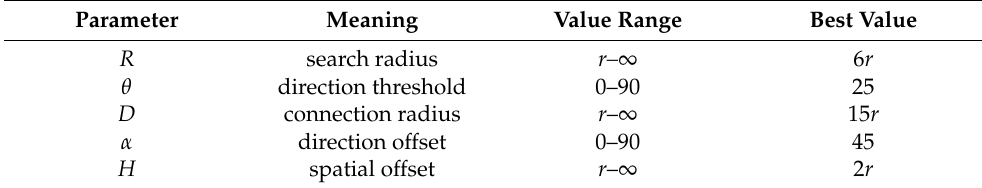
Table 2. Parameter settings for connecting discontinuity traces. Parameter Meaning Value Range Best Value R search radius r– ∞ 6 r θ direction threshold 0–90 25 D connection radius r – ∞ 15 r α direction offset 0–90 45 H spatial offset r – ∞ 2